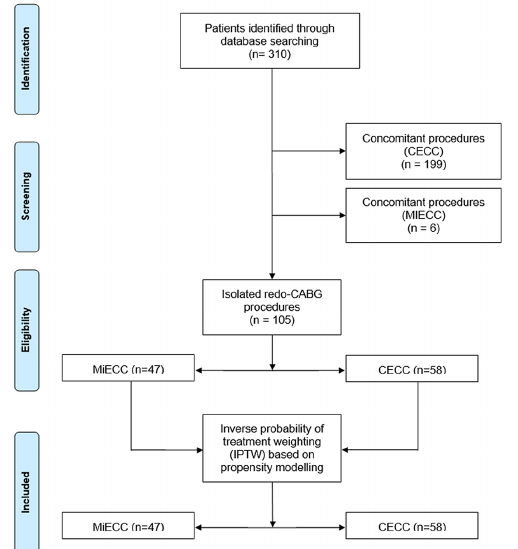
Figure 1: Study flowchart. CABG: coronary artery bypass graft; CECC: conventional extracorporeal circulation; MiECC: minimally invasive extracorporeal